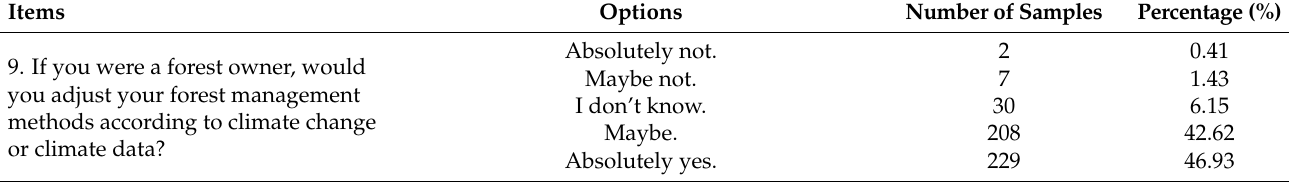
Table 7. Respondents’ thoughts on the implementation of forest adaptation measures and current